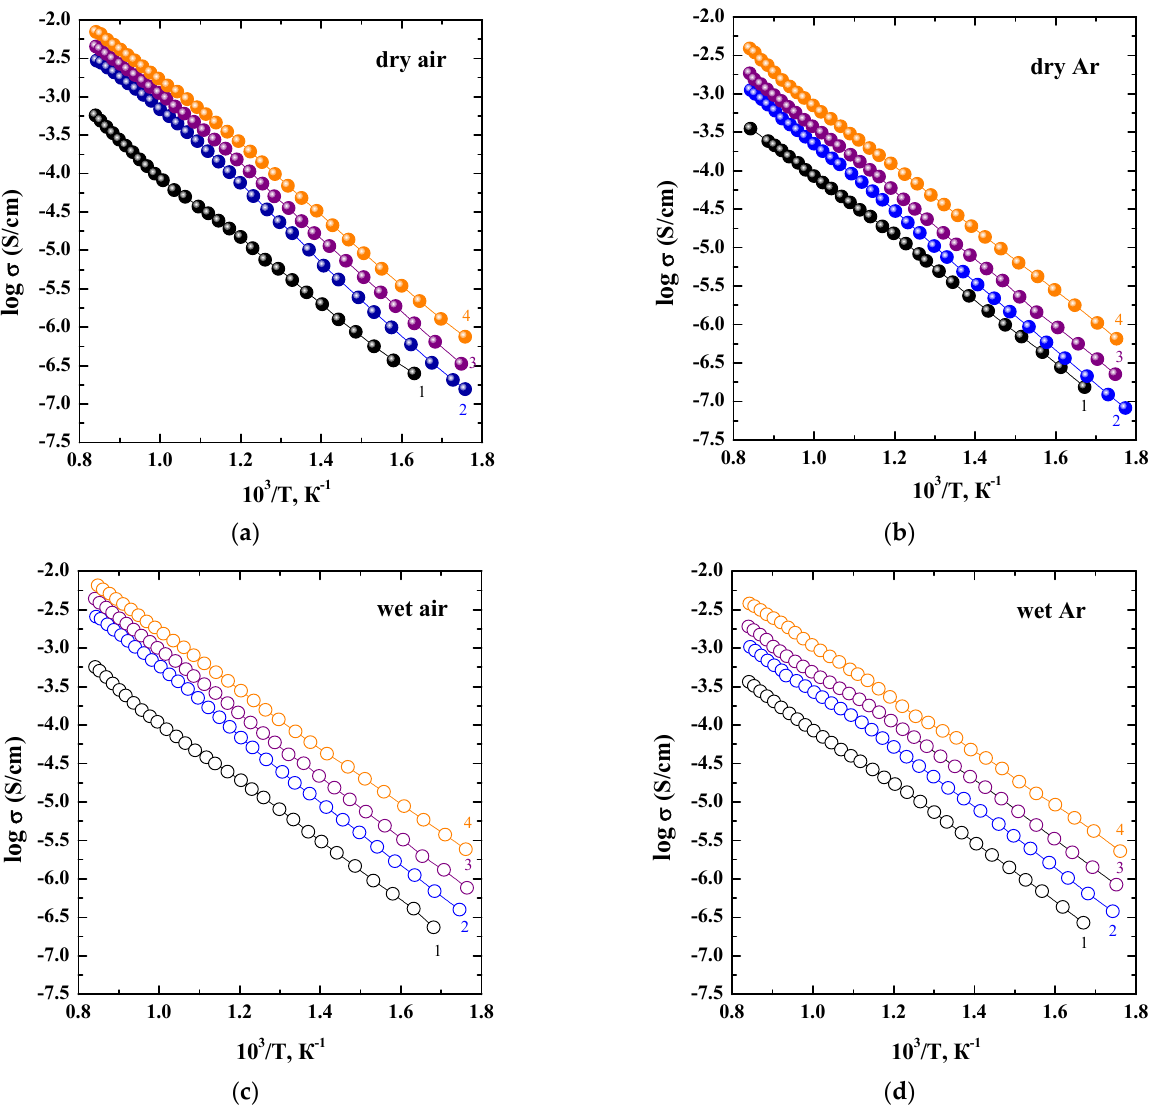
Figure 4. The temperature dependencies for the samples BaLa 2 In 2 O 7 (1), BaLa 1.85 Sr 0.05 Gd 0.1 In 2 O 6.975 (2), BaLa 1.8 Sr 0.1 Gd 0.1 In 2 O 6.95 (3), BaLa 1.75 Sr 0.15 Gd 0.1 In 2 O 6.925 (4) in dry air ( a ), dry Ar ( b ), wet air ( c ), wet Ar ( d ).